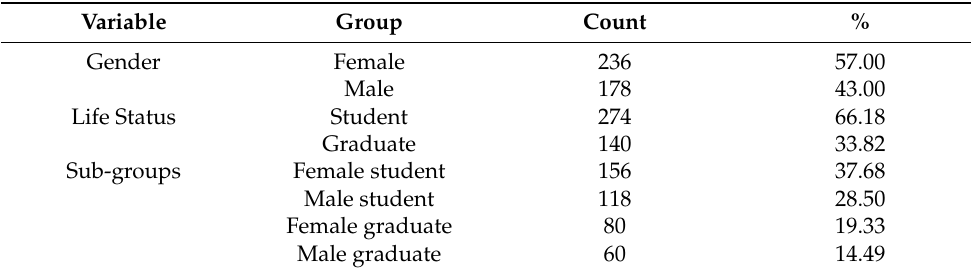
Table 2. Participant characteristics (n =